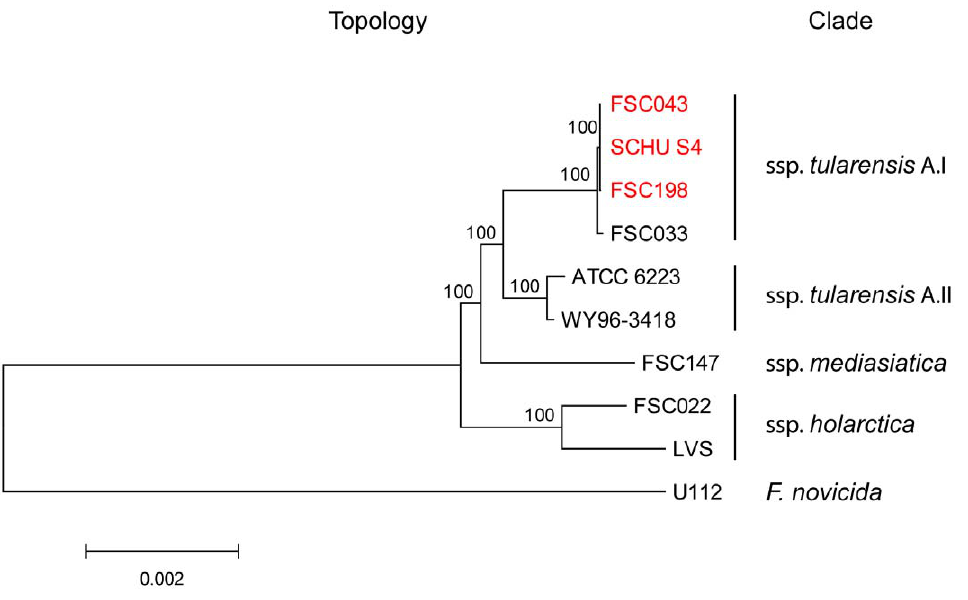
Figure 1. Relationships within the species F.tularensis . The evolutionary tree was inferred using the Neighbor-Joining method. Bootstrap support values (500 replicates) are shown next to branches. Scale bar indicates the number of base substitutions per site.